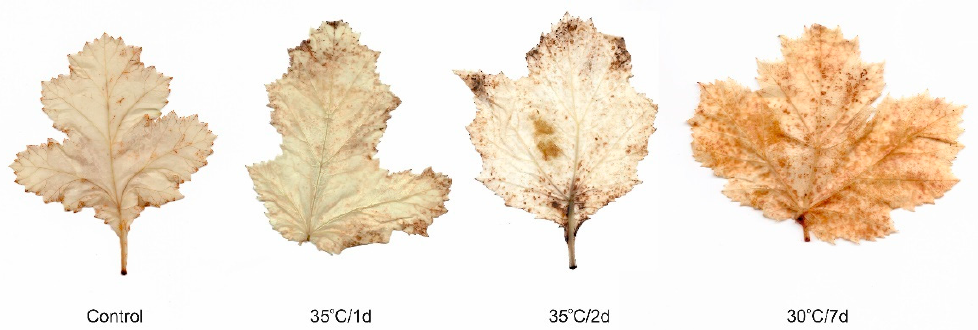
Figure 2. Histochemical detection of H 2 O 2 using DAB staining in the leaves grown under several thermal conditions. The intense brown color indicates the accumulation of H 2 O 2 .